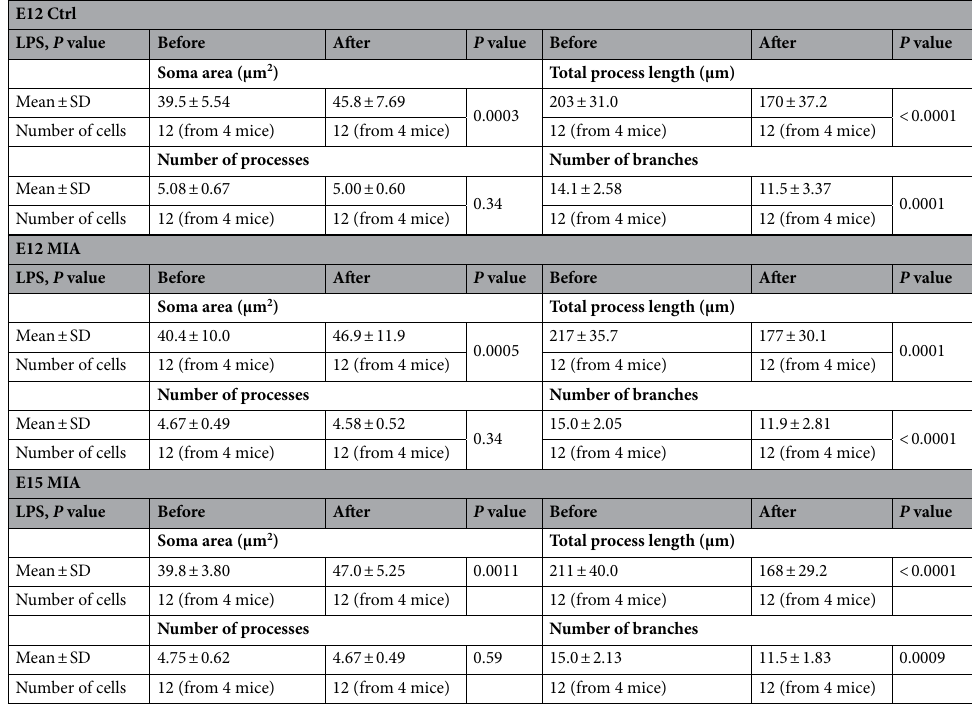
Table 7. Morphological analysis of P42 microglia with and without LPS